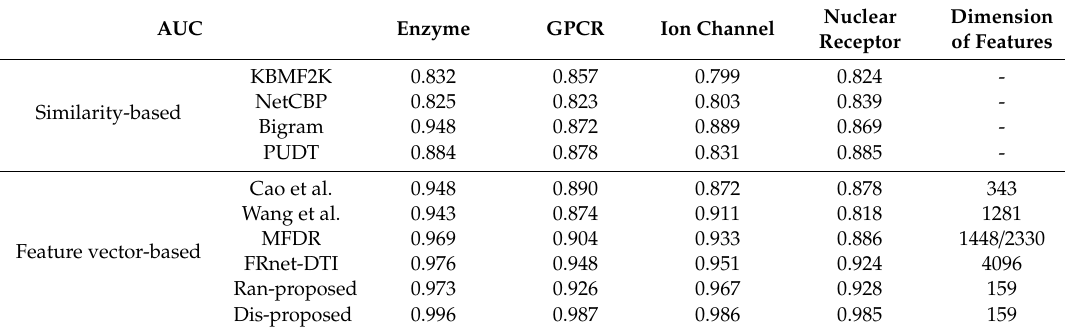
Table 2. Comparison for state-of-the-art methods on gold standard datasets. Ran-proposed and Dis-proposed represent that the methods with random and distance-based sampling for negative DTIs, respectively.